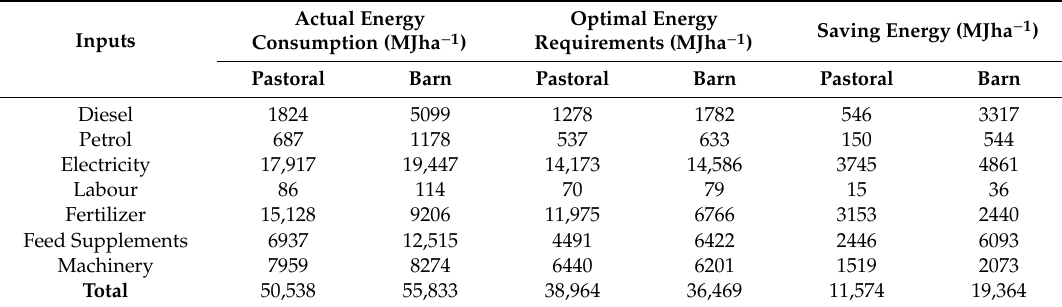
Table 5. Optimal energy requirements and energy savings capacity for both systems (50